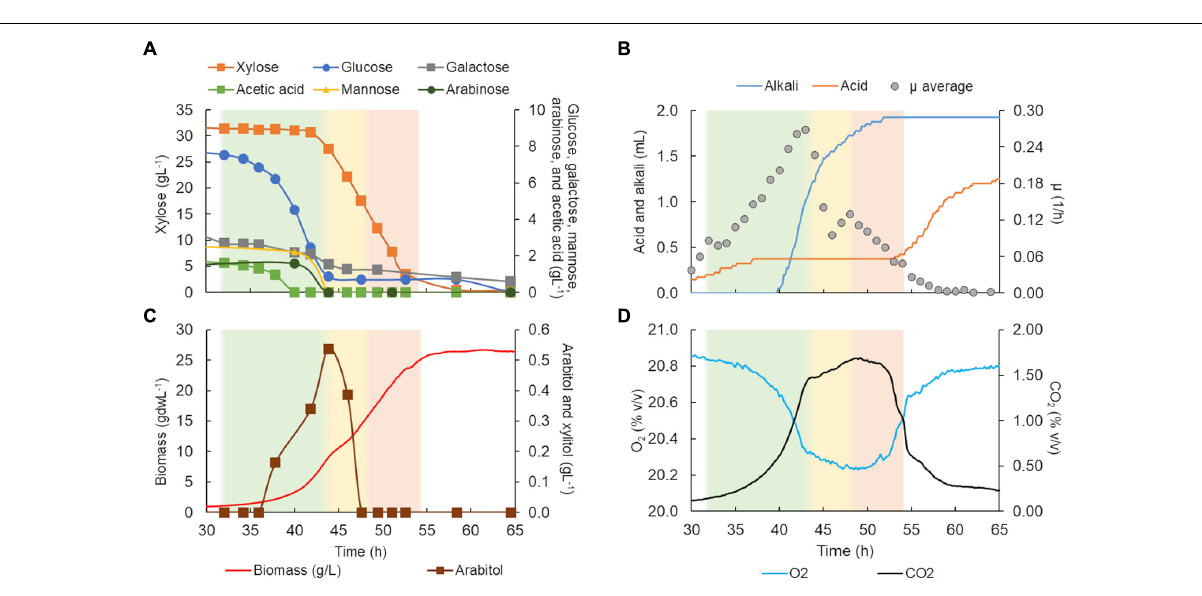
FIGURE 5 | Lipomyces starkeyi DSM 70295 characterization in a bioreactor in C5-Birch hydrolysate diluted to 50 gL − 1 of total sugars. (A) Xylose, glucose, galactose, mannose, arabinose, and acetic acid consumption profiles (gL − 1 ); (B) added alkali and acid profiles to maintain the constant pH and average specific growth rate ( µ , h − 1 ); (C) xylitol and arabitol production and consumption profiles (gL − 1 ) and growth profile in biomass (gdwL − 1 ); and (D) CO 2 production and O 2 consumed gases profiles. The lag and stationary phases are depicted in white (the graph stated at 30 h); the first, second, and third growth phases are shown in green, yellow, and light orange, respectively. Supplementary Table 5 contains all data and errors expressed in standard